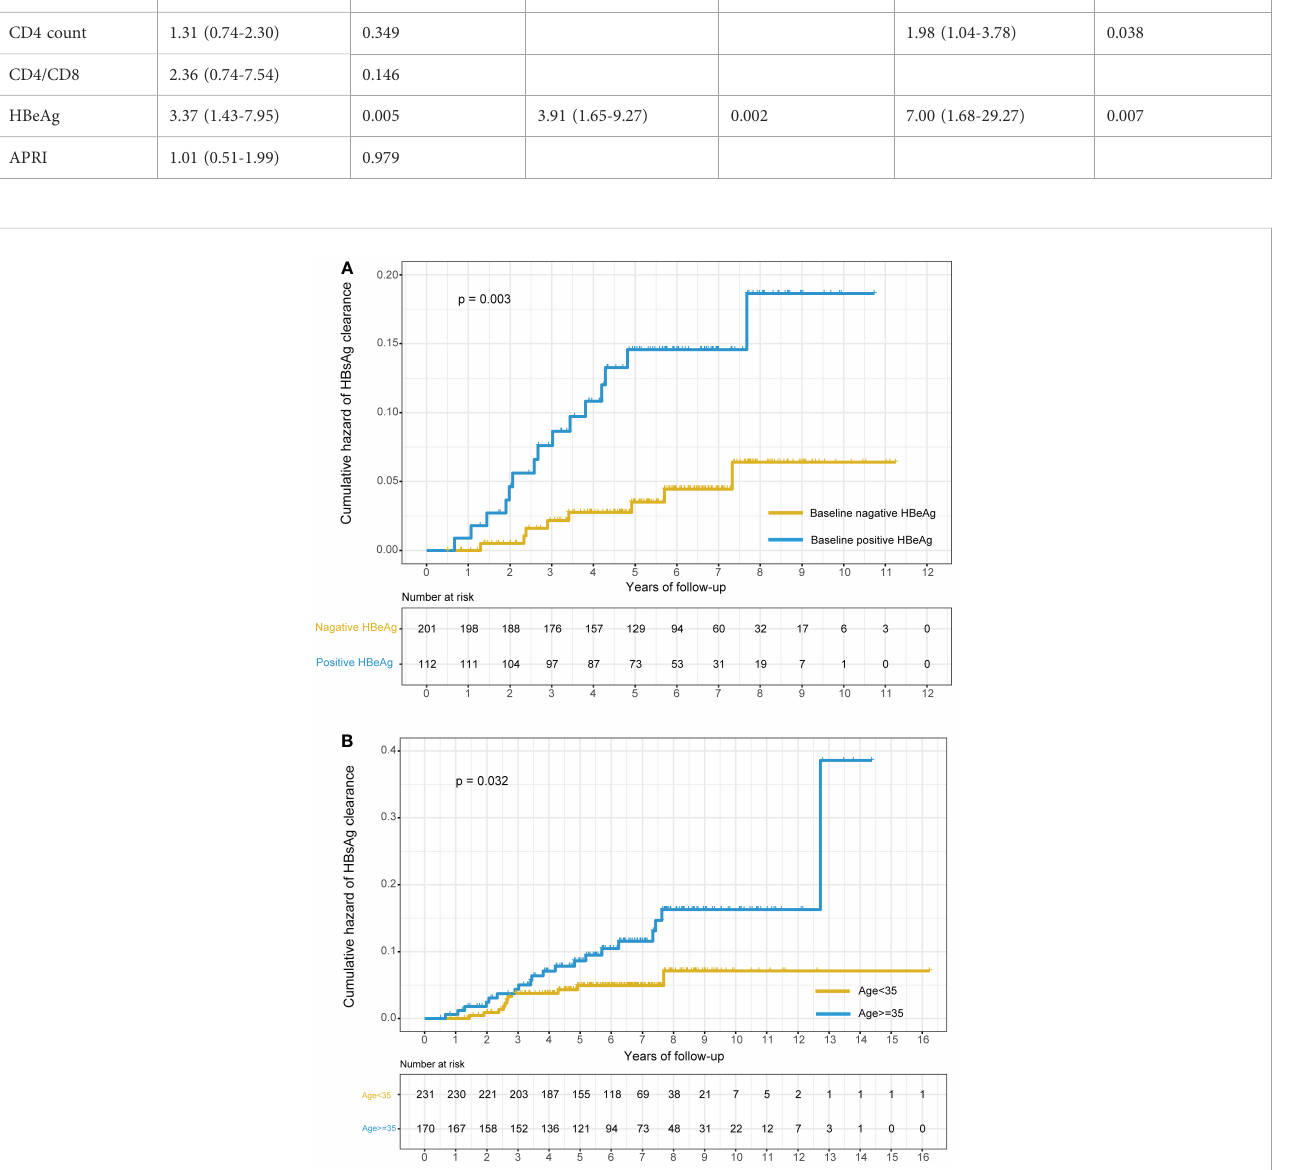
FIGURE 3 Kaplan – Meier plots of the cumulative hazard of HBsAg clearance strati fi ed by the baseline status of HBeAg and age. (A) Strati fi ed by the baseline status of HBeAg (positive HBeAg at baseline or negative HBeAg at baseline); (B) strati fi ed by age (age<35 or age>=35).